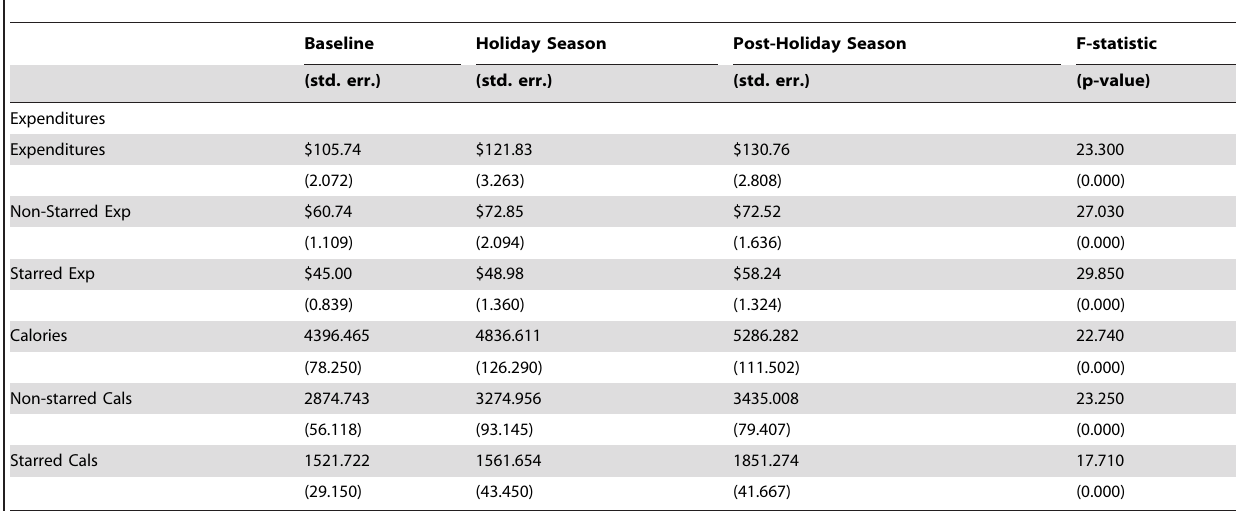
Table 1. Predicted Average Expenditures and Calories During the Baseline, Holiday, and Post-Holiday Periods.